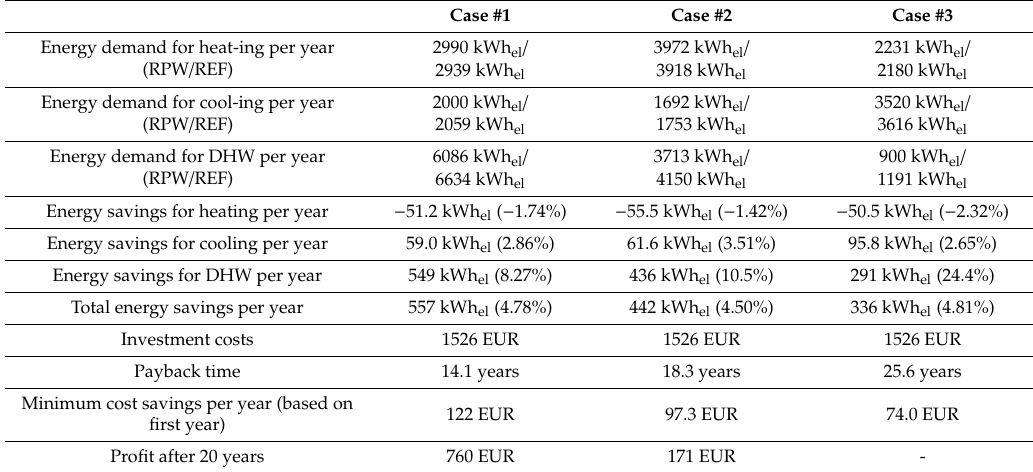
Table 3. Performance of systems with 5 kWh RPW-HEX and medium DHW storage devices working in standard-operation mode.